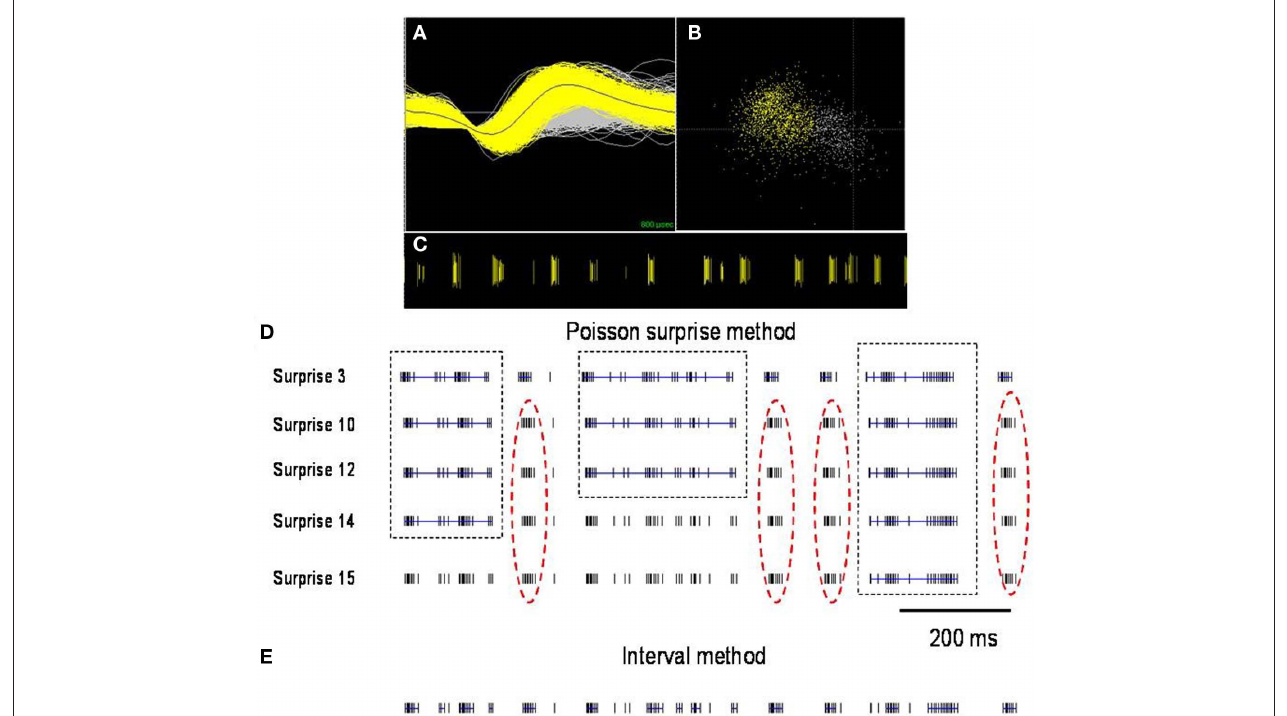
values, the Poisson surprise method wrongly classifies adjacent burst periods as one single burst (dashed boxes) and with higher surprise values, obvious bursts are rejected by the algorithm (red dashed oval). (e) The interval method provides greater reliability for defining individual burst periods. Blue lines indicate bursts detected in the spike trains using the two illustrated burst